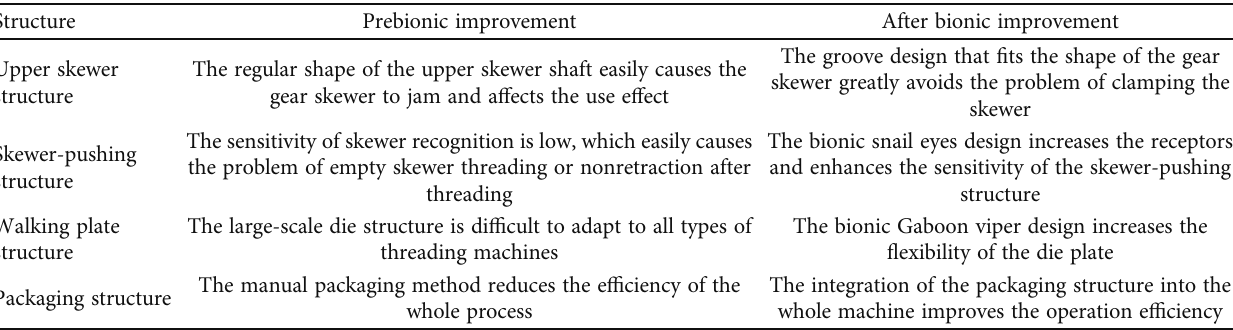
Figure 16: The gear piercing threading machine. Table 7: The comparison of the scheme before and after